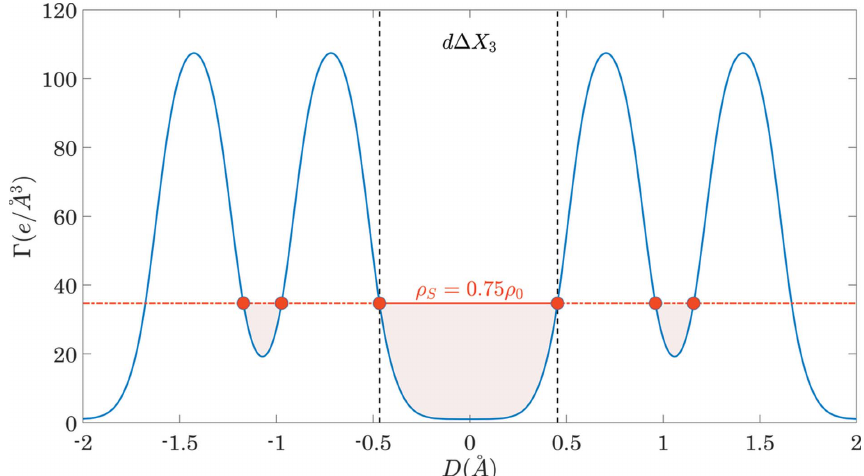
Figure 1 A graphical illustration of the definition of C hkl according to equation (7). The solid line shows an arbitrary (cid:2) ( hkl , D ) function extending over two unit cells (one unit cell on the positive and one unit cell on the negative side of the D axis). The dashed horizontal line shows the threshold value of (cid:2) S = 0.75 (cid:2) 0 . The regions of (cid:2) ( hkl , D ) < (cid:2) S are filled by colour. The numerator of equation (7) is equal to the area inside the coloured Uriel Vaknin et al. (cid:5) Geometrical prediction of cleavage planes in crystal structures